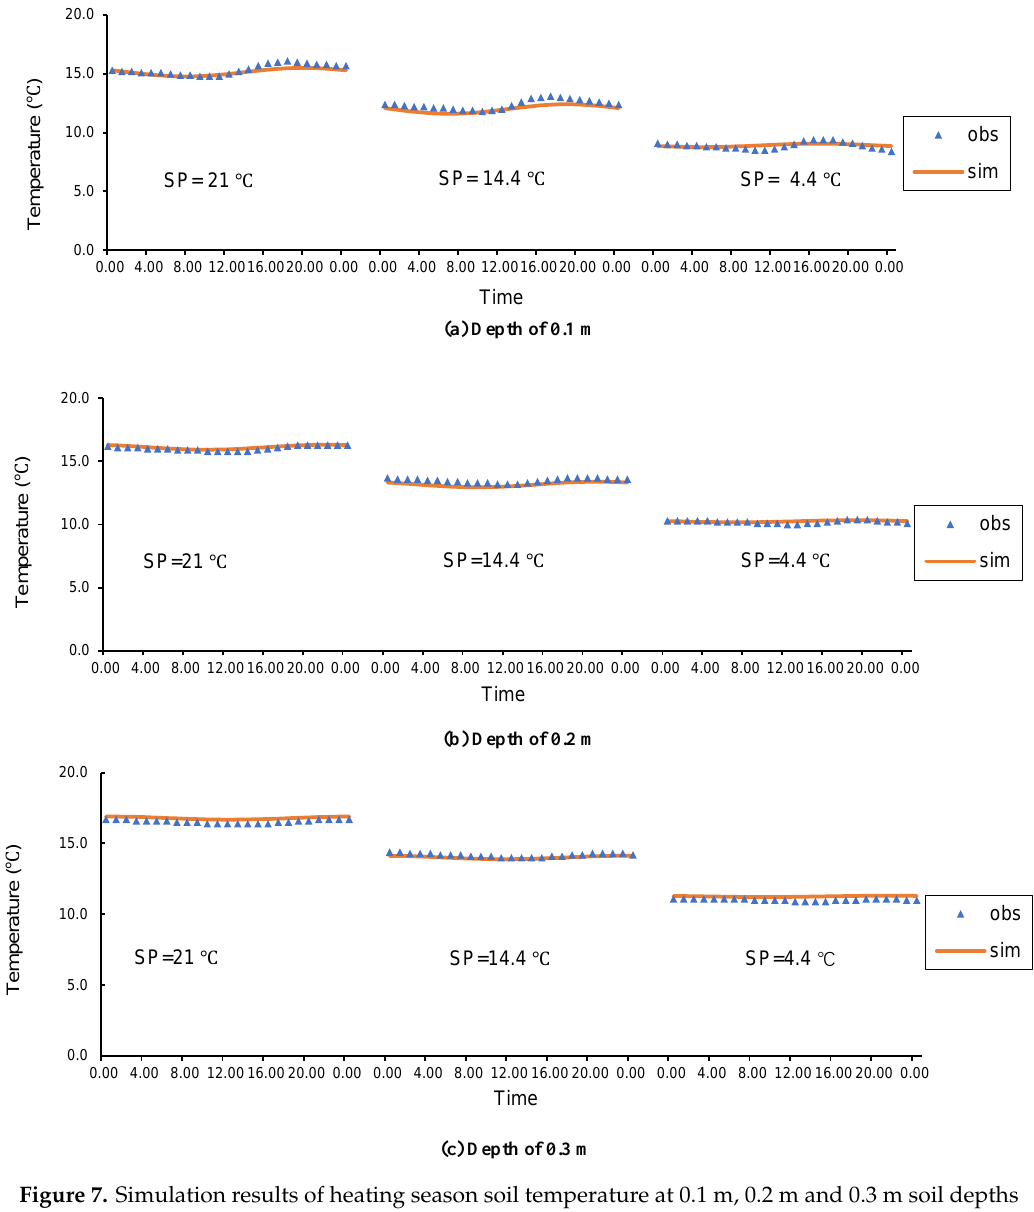
Figure 7. Simulation results of heating season soil temperature at 0.1 m, 0.2 m and 0.3 m soil depths from the soil su4rface temperature at different heating set points (21 ° C, 14.4 °C and 4.4 °C).